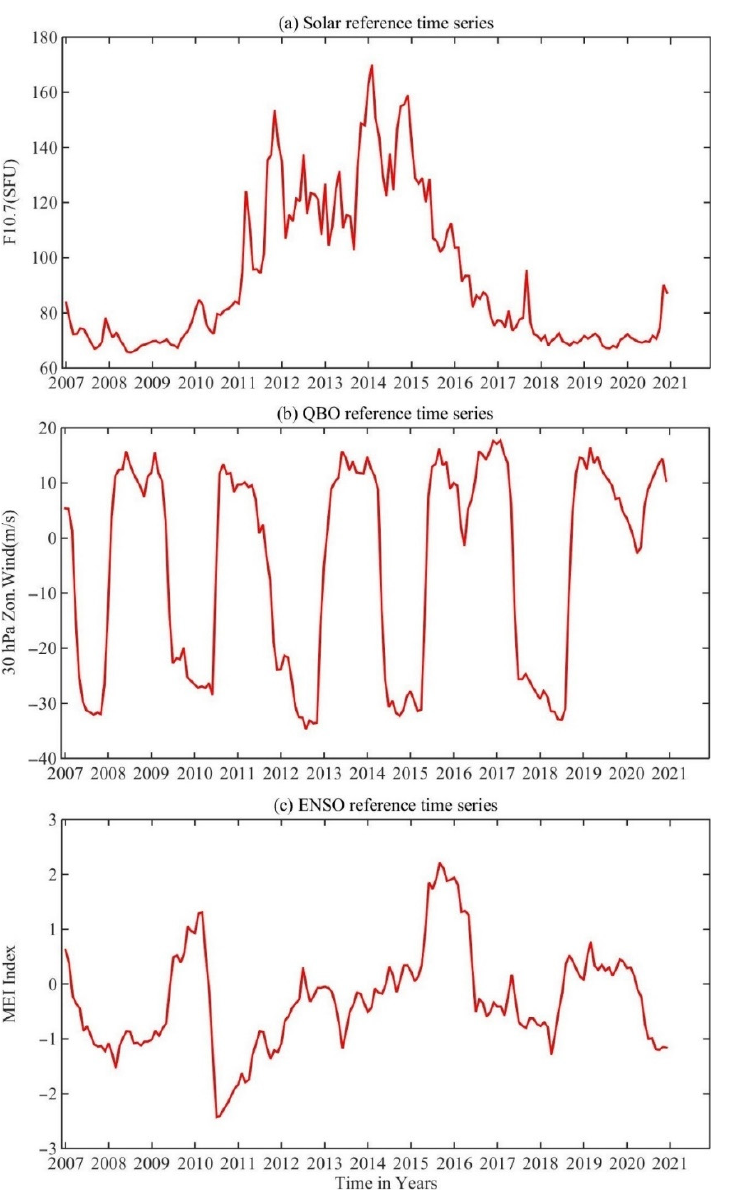
Figure 3. Variations in the monthly values for ( a ) Solar radio flux at 10.7 cm (F10.7) index, ( b ) 30 hPa zonal winds over the equator, used as QBO index, and ( c ) Multivariate ENSO Index (MEI)